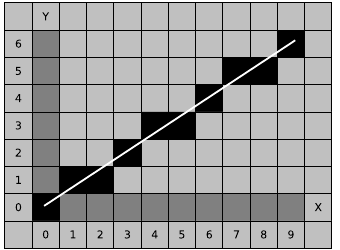
Figure 10. True line and its